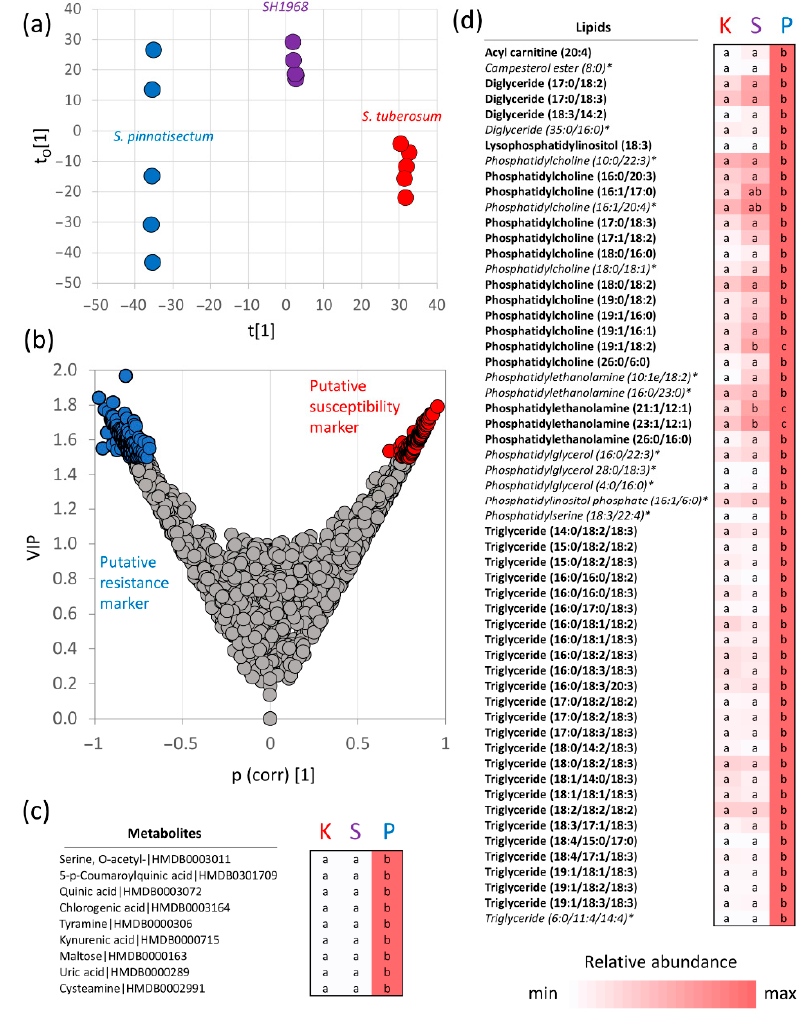
Figure 6. Identification of proteins, lipids, and metabolites correlating with Phytophthora resistance . Orthogonal partial least squares discriminant analysis ( a ) followed by VIP (variable importance in projection), ( b ) lists of identified metabolites, ( c ) and lipids ( d ) that separate the resistant genotype. Only metabolites with confident identification are shown with the corresponding HMDB metabolite identifier (https://hmdb.ca/; accessed on 10 December 2021). Heat maps represent the mean relative abundances of five biological replicates compared to S. pinnatisectum ; letters represent the results of ANOVA and Fisher’s LSD post hoc analysis; asterisks indicate identification of lipid compounds with lower confidence. For details, see Supplementary Materials Tables S1, S3–S5. Putative protein markers are summarized in Figure